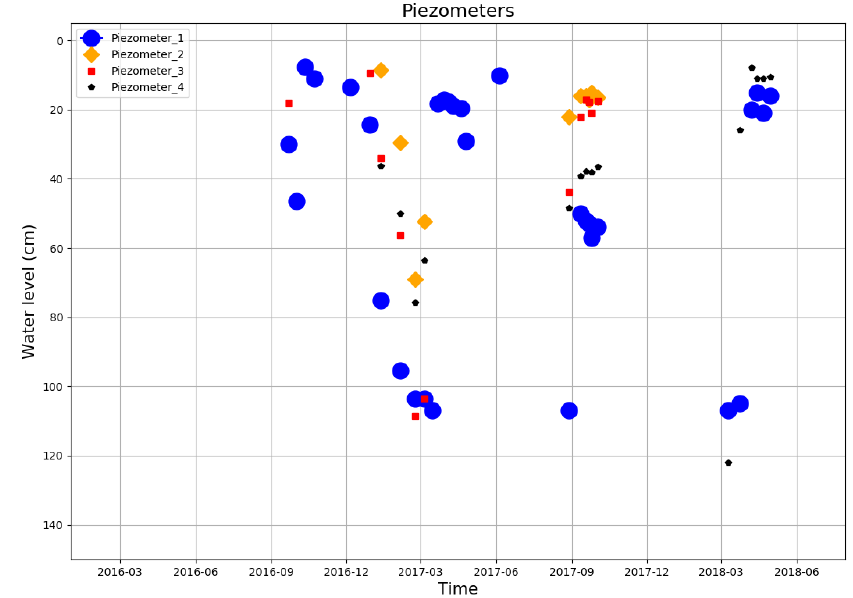
Figure 6. Piezometric levels measured within the study site, represented as cm below ground level. Piezometers are numbered from 1 to 4, from top to bottom of the study site (see Figure 1 for piezometer locations).